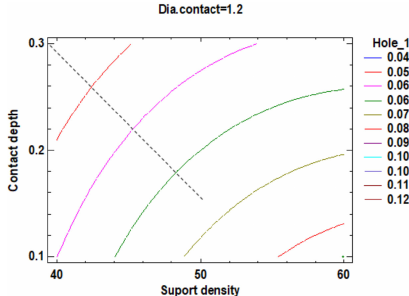
Figure 31. Contours of Estimated Response Surface for Roundness Hole_15 and centre diameter